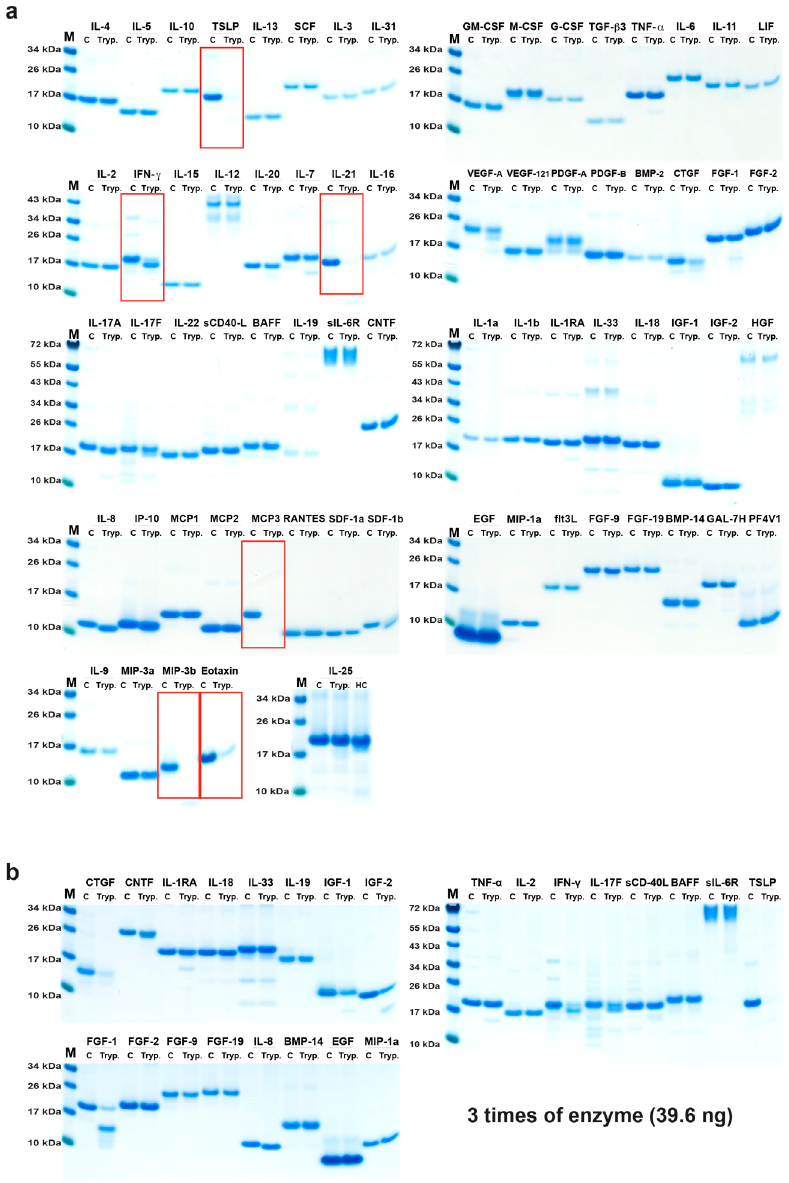
Figure 2. Cleavage analysis of a panel of 69 recombinant human cytokines and chemokines. The various recombinant cytokines and chemokines were divided into two separate tubes. One was kept as negative control (C) where PBS (no enzyme) was added and one was cleaved with the human tryptase. The cleavage was performed at 37 °C in PBS buffered solution (pH 7.3) for 2.5 h. The samples were separated on 4–12% SDS-PAGE gels under reducing conditions. Size markers are found at the left side of each gel. The gels were stained in colloidal Coomassie blue solution. ( a ) Cleavage with 13 ng of tryptase. ( b ) Cleavage using three times higher enzyme concentration. The cytokines and chemokines that were efficiently cleaved or trimmed are marked by red rectangles.